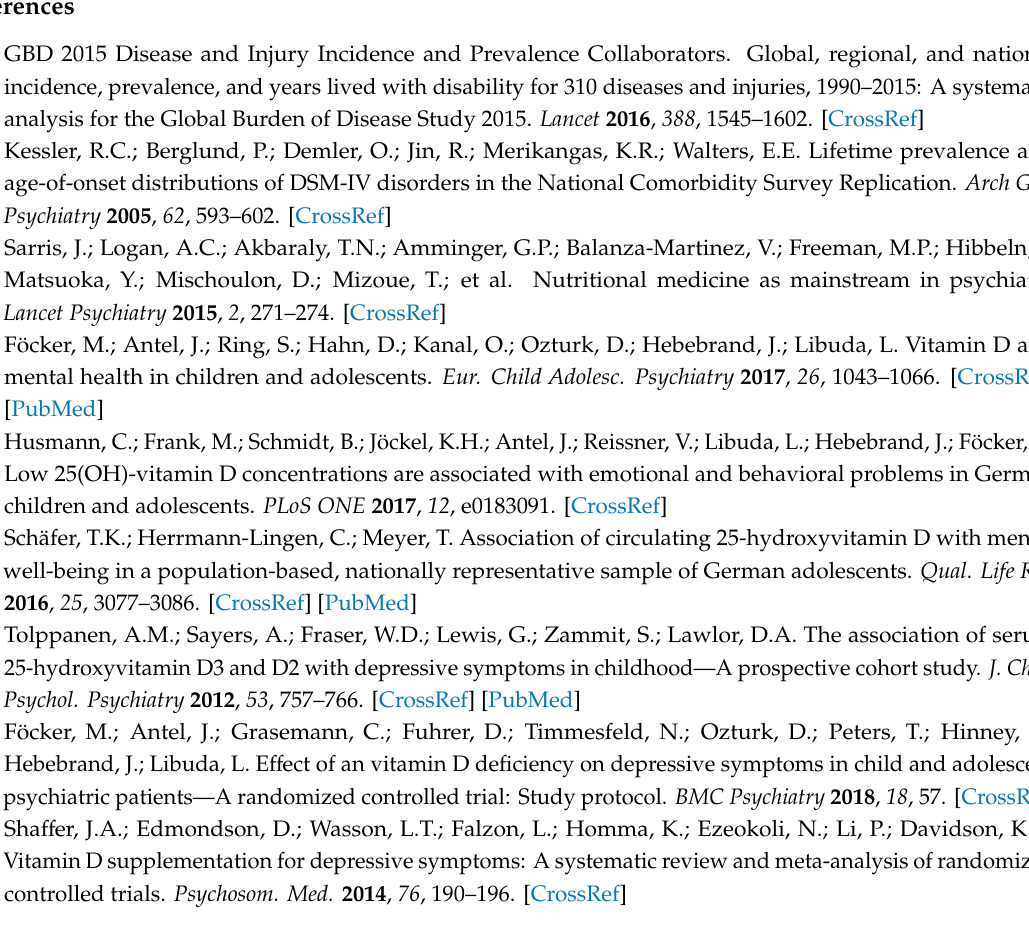
Table S1: Sensitivity analyses using the leave-one-out approach on the association of natural-log transformed 25(OH)vitamin D concentrations with broad depression, Table S2: Sensitivity analyses using the leave-one-out approach on the association of natural-log transformed 25(OH)vitamin D concentrations with depressive symptoms. Figure S1. Calculated power to detect a true causal e ff ect of a relative di ff erence between 1% and 20% per 1 standard deviation in 25(OH)vitamin